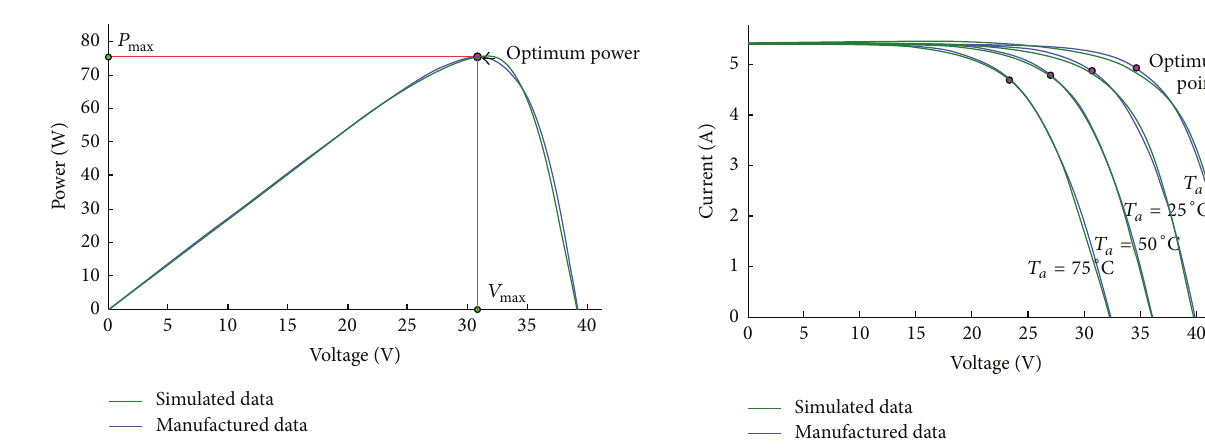
Figure 3: Typical P-V characteristic curve of a PV module.